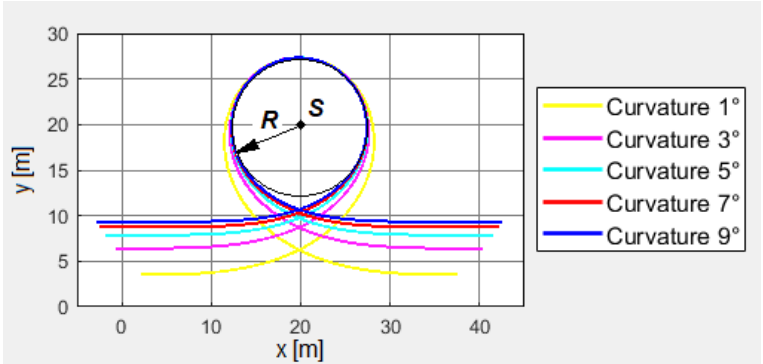
the linear function as well as the third, fifth, seventh, and ninth degree polynomials.